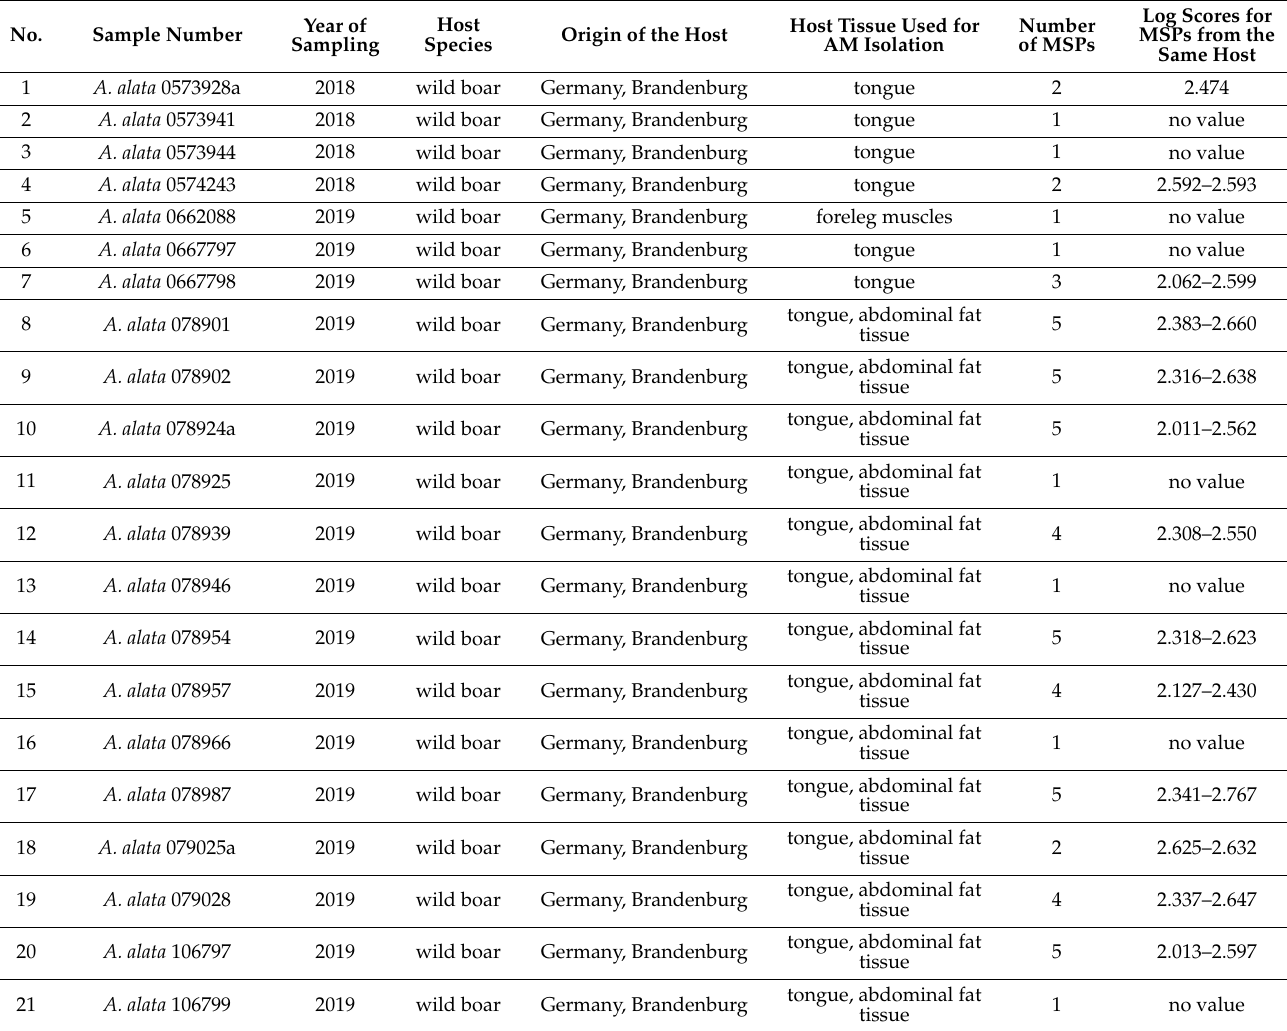
Table 1. List of Alaria alata mesocercariae included in this study. The 8th column of this table gives the log score values for comparison of at least two main spectra profiles created from the same host individual.